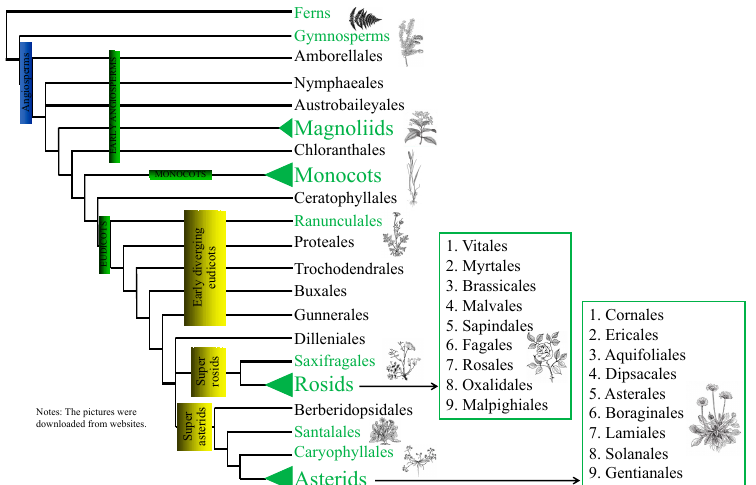
Rosids CaryophyllalesSantalalesBerberidopsidales Asterids Figure 4. A simplified phylogenetic tree showing major orders that include Cassytha filiformis hosts. The green labels indicate the host positions among the vascular phylogenetic relationships. The host range of C. filiformis spanned most of the vascular plants (Figure 4), with six ferns ( Adiantum capillus-veneris L., Blechnopsis orientalis C. Presl, Dicranopteris pedata (Houttuyn) Nakaike, D linearis (Burm.) Underw., Lygodium japonicum (Thunb.) Sw., and Pteris sp. L.) and three conifers ( Cunninghamia lanceolata (Lamb.) Hook., Keteleeria fortunei (Murr.) Carr., and Pinus massoniana Lamb.) parasitized by C. filiformis (Figure 5). In the flowering plants, rosids were common hosts, with Malpighiales containing the largest number of host species (twenty-two species), and Sapindales containing the largest number of infected genera (fifteen genera), while the asterid order Ericales had the most host families (seven) (Figures 4 and 5; Table S1). Euphorbiaceae was the largest single family with eight genera and thirteen species (Figure 5; Table S1). The order Gentianales represented the widest array of host plant growth forms, including the tree Psychotria rubra (Lour.) Poir., shrub Wendlandia aberrans Cowan, herb Hedyotis auricularia L., and liana Cryptolepis buchananii Roem. et Schult (Figure 5). Four angiosperm families had at least 10 host species (Table S1): Rubiaceae (12), Lauraceae (11), Phyllanthaceae (11), and Asteraceae (10). These results differ from the study by Zhang et al. [6], where they reported seven families at the world level with at least 10 host species: Anacardiaceae, Asteraceae, Euphorbiaceae, Fabaceae, Myrtaceae, Phyllanthaceae, and Rubiaceae. This confirms that C. filiformis is a generalist hemiparasite that is associated with many host species. These species are relatively common (Figures 4 and 5), with no obvious evolutionary relationships, as observed by Zhang et al. [6].